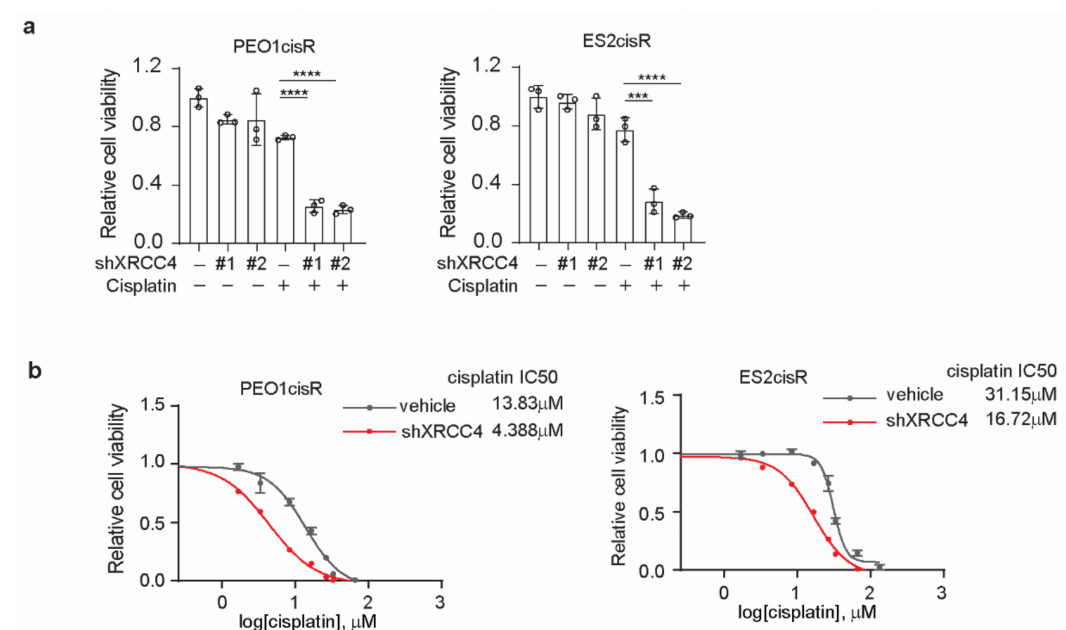
Figure A2. Knockdown of XRCC4 sensitized cisplatin treatment in the cisplatin-resistant ovarian cancer cells. ( a ) Cell viability of XRCC4 knockdown or vehicle control PEO1cisR and ES2cisR cells treated with or without sublethal doses of cisplatin (1.5 µ g/mL PEO1cisR and 4 µ g/mL ES2cisR) for 48 h. ( b ) Cisplatin IC50 of PEO1cisR and ES2cisR with or without XRCC4 knockdown. *** p < 0.001; **** p <